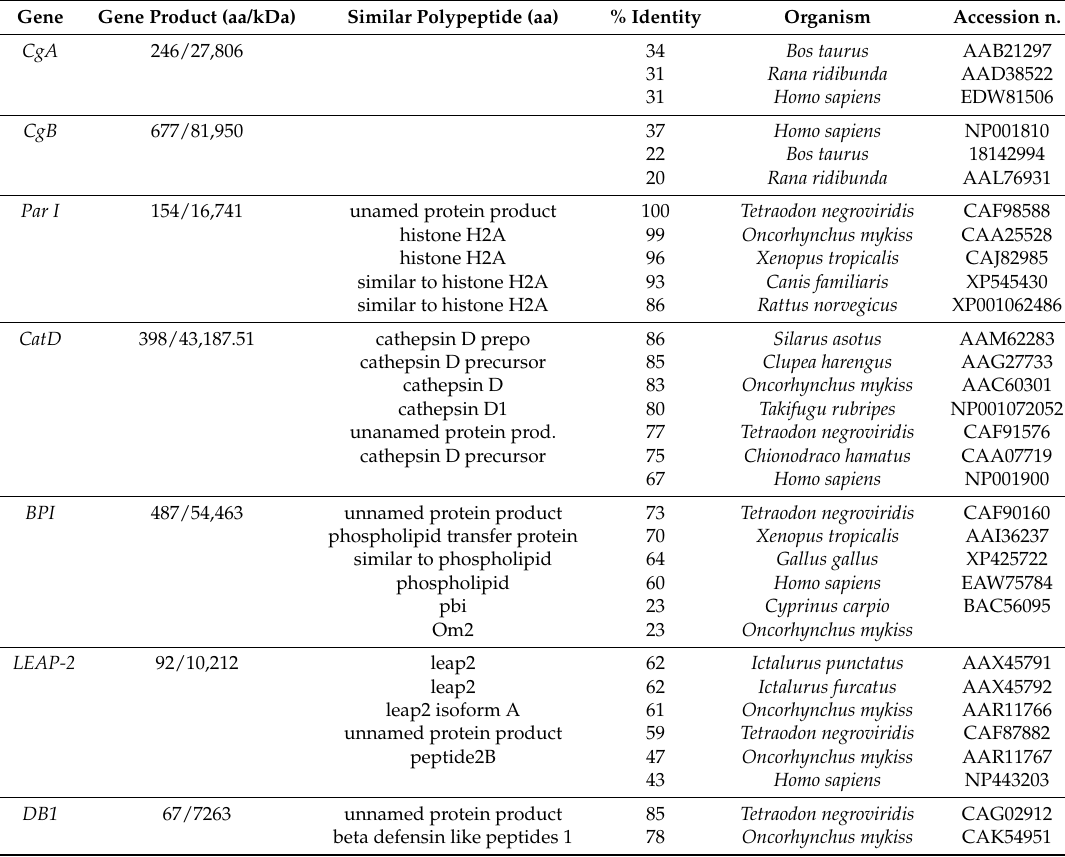
Table 2. Homology of amino acid sequences of zebrafish parasin I.